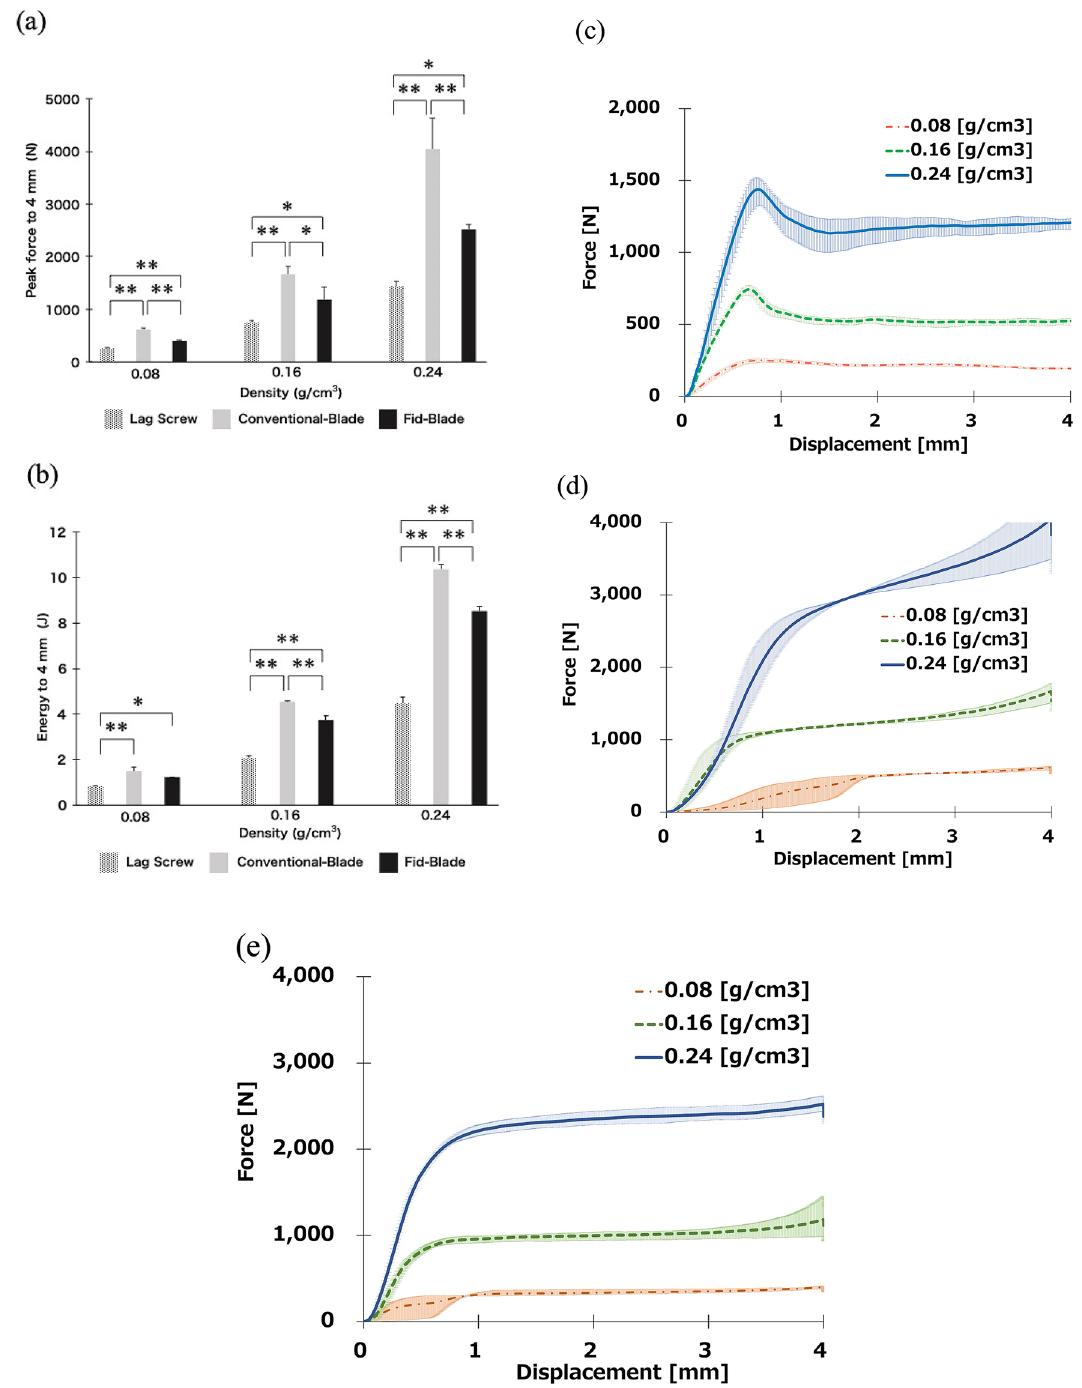
Figure 4. Push-in test. ( a ) Mean peak force to achieve a 4-mm displacement. ( b ) Mean energy force to achieve a 4-mm displacement. * P < 0.05. ** P < 0.01. ( c – e ) Mean force–displacement curves. ( c ) Lag screw. ( d ) Conventional-Blade. ( e )